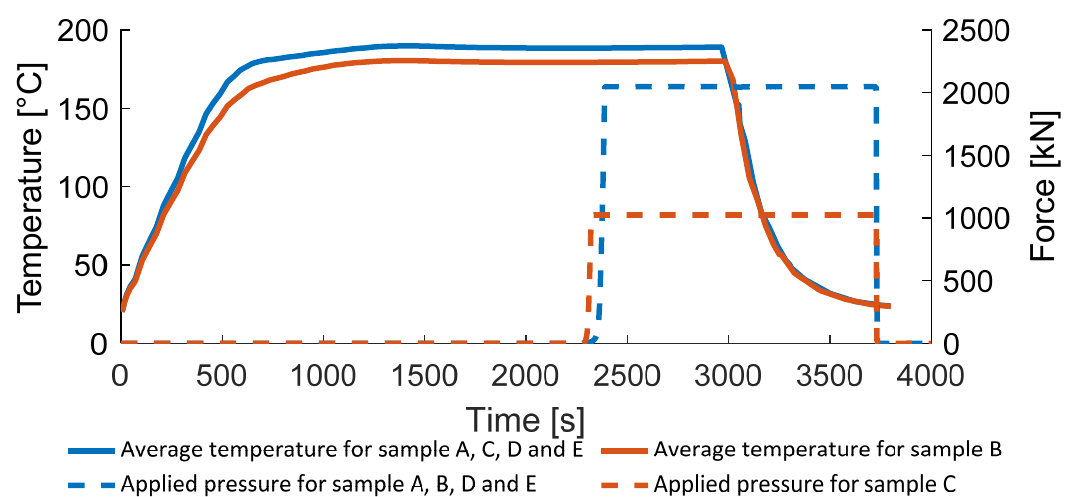
Figure 10. Temperature and pressure applied in the experiments.